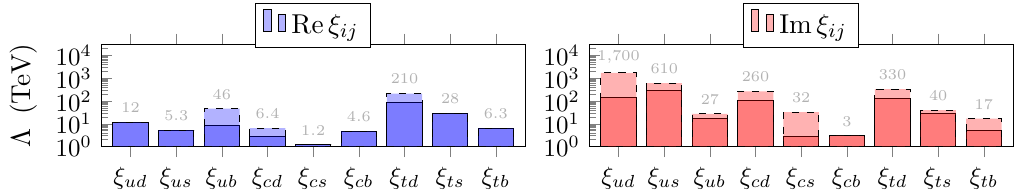
Figure 10 . The (cid:12)gure summarizes the most stringent naive constraints on (cid:24) ij . The dashed bars show the naive constraints in the case that we do not take into account the theory errors that appear in the EDM expressions eqs. (5.3) and (5.4). Notation is the same as in (cid:12)gure 6.